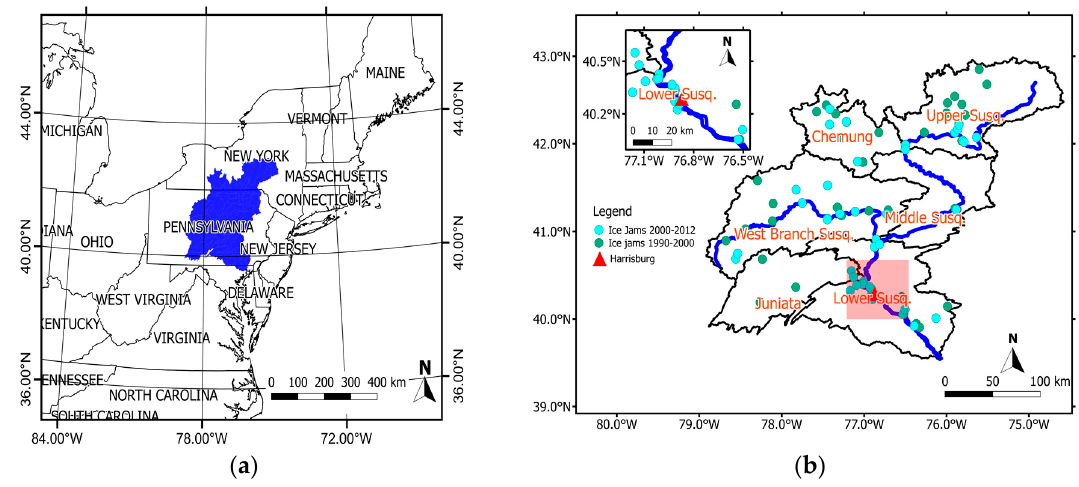
Figure 2. ( a ) The general location of the Susquehanna River basin (blue); and ( b ) its sub-basins (black), major river branches (blue) and locations of past ice jams (teal) obtained from the Ice Jam Database (Available at http://icejams.crrel.usace.army.mil/). The region of study is indicated by the map inset, and is approximately centered at Harrisburg, PA, USA.